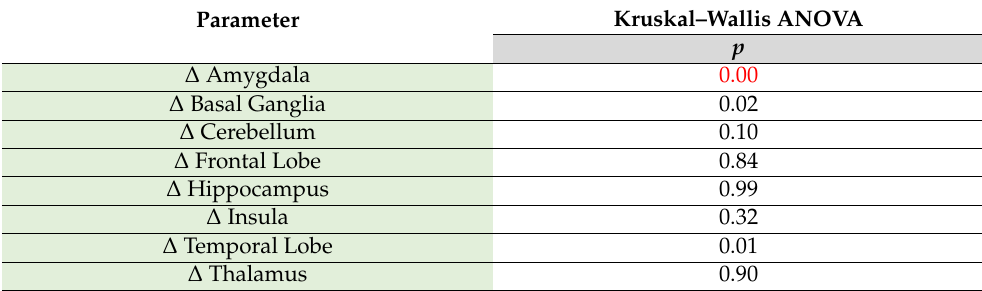
Table 2. Descriptive